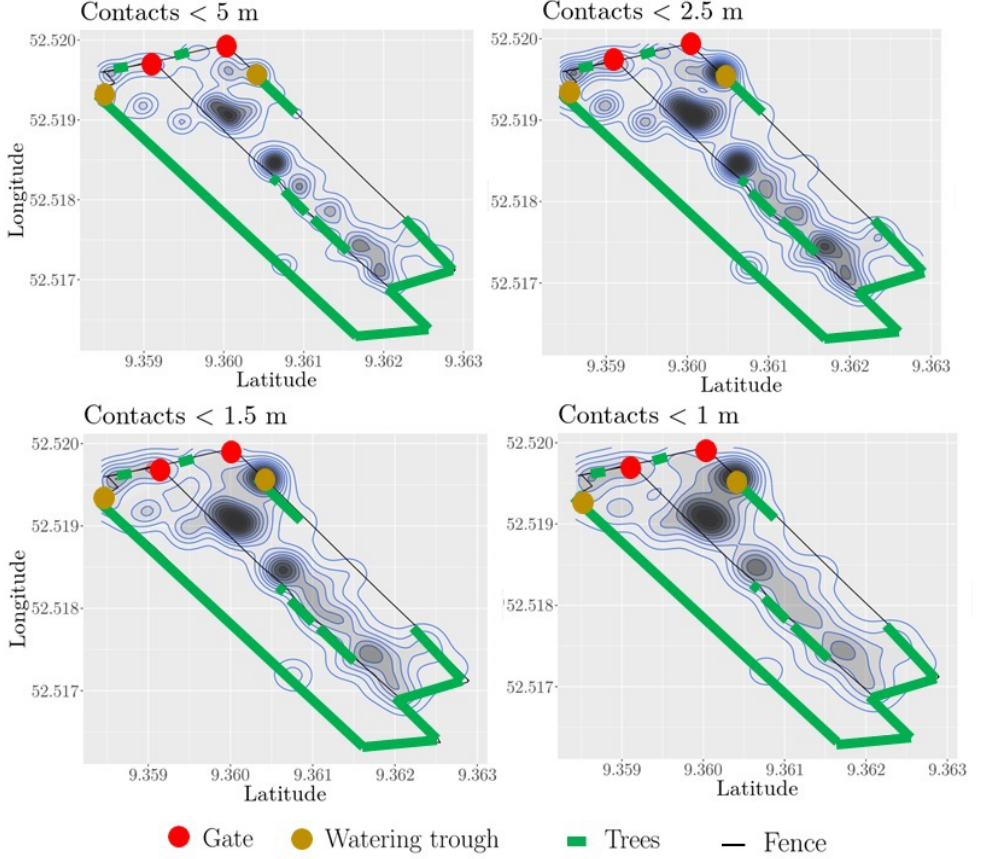
Figure 3. Contact zones of heifers. The dark zones mark the areas of a high number of pairwise contacts, i.e., the distance between heifers is less than a distance threshold (1 m, 1.5 m, 2.5 m, 5 m). Black thin lines indicate the fence of the pasture; the middle fence separates the eastern from the western part. The gate (red) at the middle fence is open, and the heifers can move freely between the eastern and western pasture